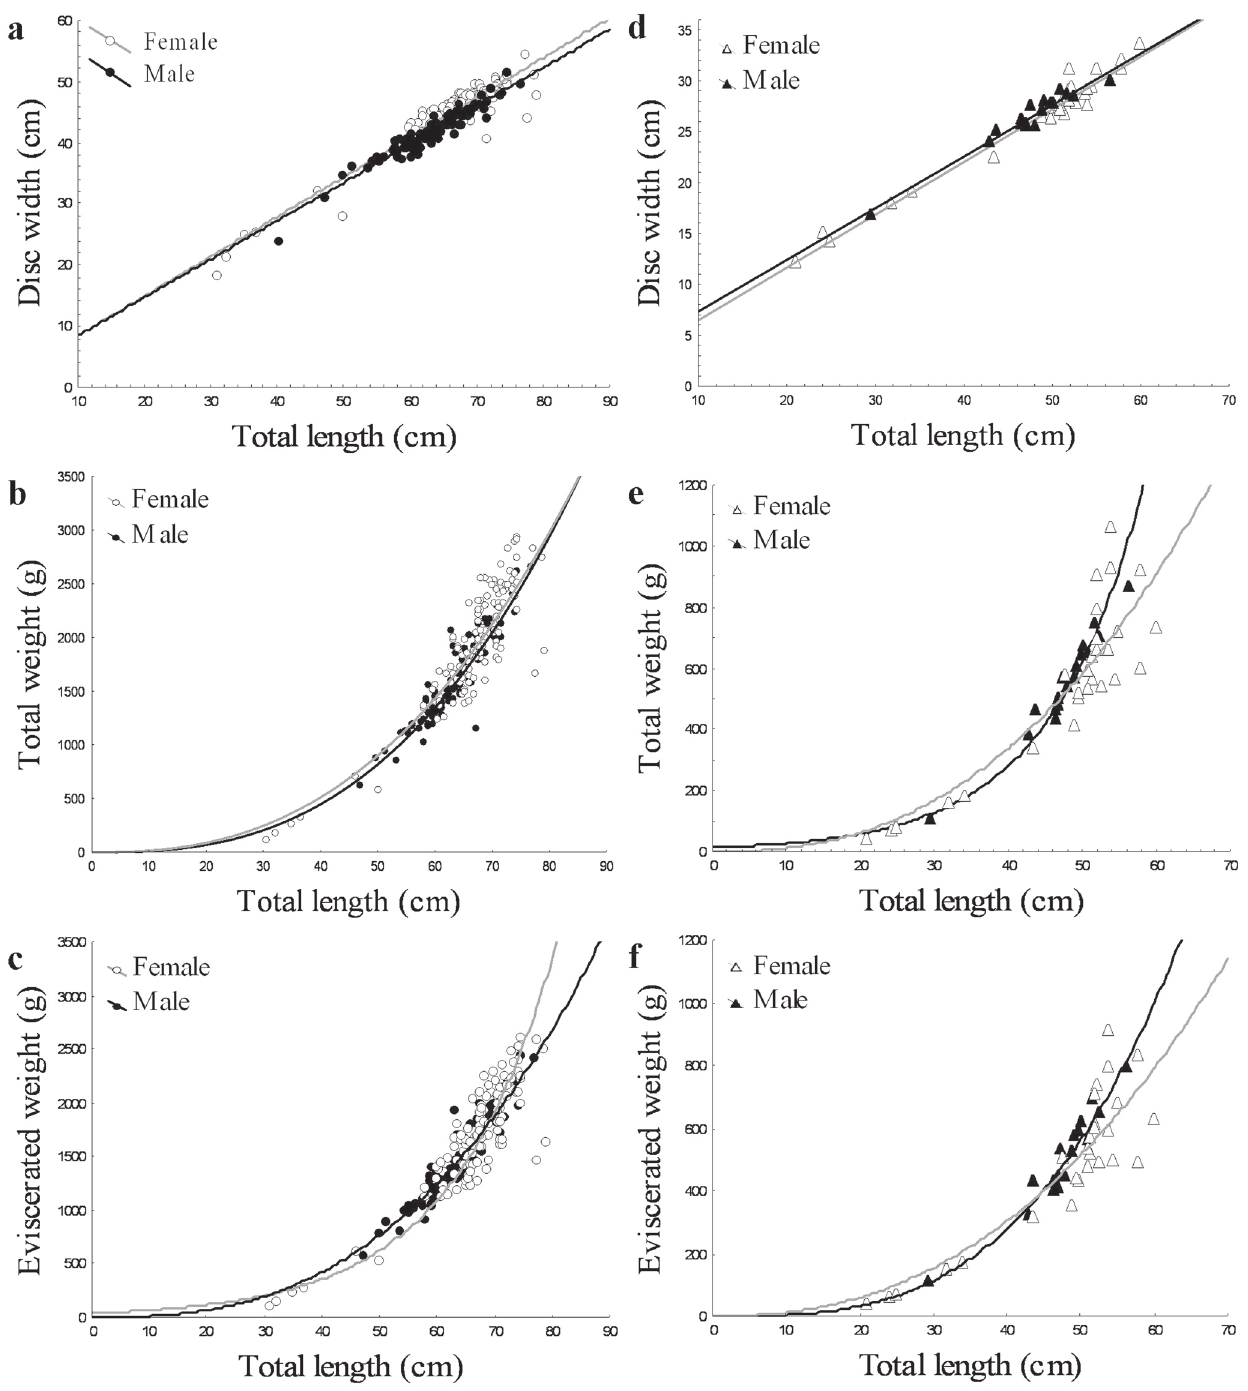
(g).(mean=53.65; SD=3.08; n=11). Egg-bearing females had values between 47.7 and 58.0 cm TL (mean=53.14; SD=3.74; n=5). The relationship between TL and DW in females was linear (Fig. 2d) (Table 1). In S. acuta the relationships between TL- DW, TL-TW and TL-EW showed significant differences (Table 1, Fig. 2